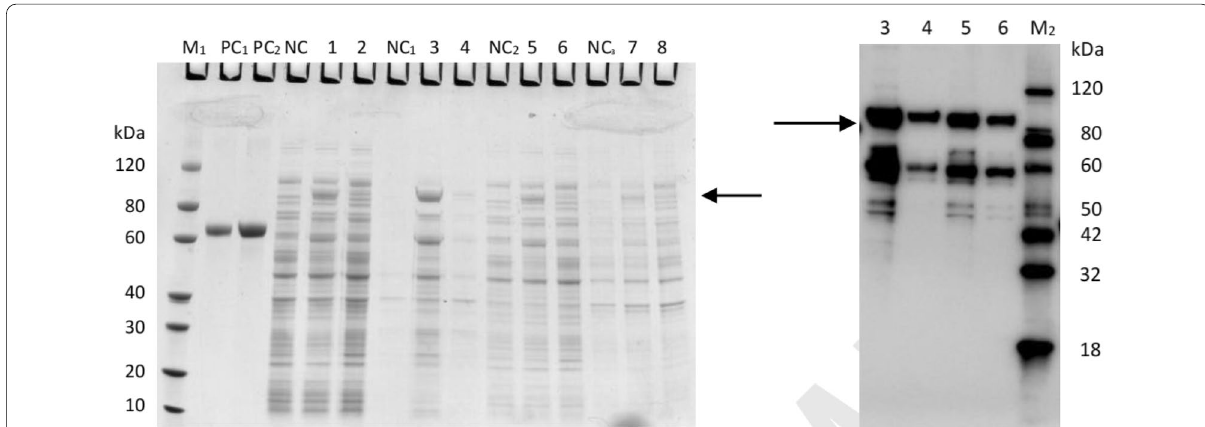
Fig. 13 SDS‑PAGE result (left) and western blot (right) of MT‑CalB. Lane M 1 : protein marker; Lane M 2 : western blot Protein marker; Lane PC 1 : BSA (1 μg); Lane PC 2 : BSA (2 μg); Lane NC: uninduced whole cell; Lane 1: whole cells were induced at 26 oC for 16 h; Lane 2: whole cells were induced at 15 oC for 16 h; Lane NC 1 : uninduced pericytoplasm; Lane 3: periplasmic cells were induced at 26 oC for 16 h; Lane 4: pericytoplasm was induced at 15 oC for 16 h; Lane NC 2 : uninduced supernatant of cell lysis; Lane 5: induced cell lysis supernatant at 26 oC for 16 h; Lane 6: cell lysis supernatant was induced at 15 °C for 16 h; Lane NC 3 : uninduced cell lysis precipitation; Lane 7: 26 °C Induced cell lysis precipitation for 16 h; Lane 8: induced